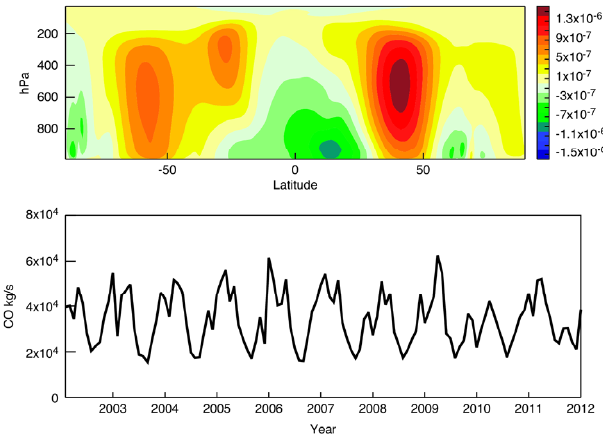
Figure 2. Cross section at 180 ◦ E of the average zonal CO flux (kgm − 2 s − 1 ) in the 2003–2012 period calculated from the CO, U and density fields of the MACC re-analysis (top). Time series of monthly mean CO (kgs − 1 ) transported over the northern Pacific through a pane at 180 ◦ E (30–70 ◦ N, up to 300hPa)